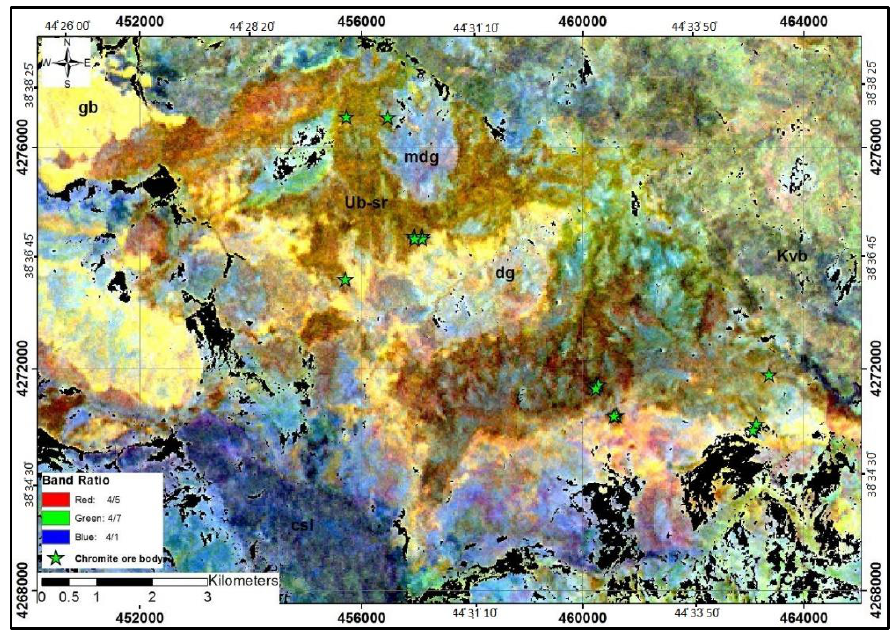
Figure 15. SATER RGB image of band ratios (4/1), (4/5), (4/7) in the study area: Ub-sr—serpentinized